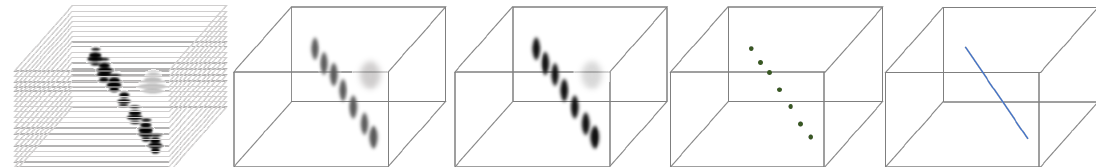
Figure 10. Schematic view of the track reconstruction sequence in a single sensitive layer of the emulsion film. From left to right: raw tomographic image stack obtained at the automated microscope; 3D voxels view; 3D voxels view after 3D filtration to enhance signal to background ratio; silver grains located in 3D space; reconstructed track from the grain position.